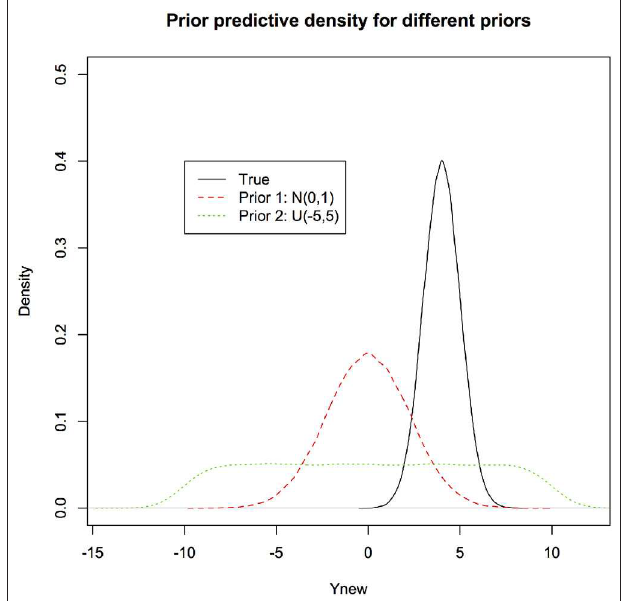
FIGURE 5 | Prior predictive densities for the linear regression through origin example under two different priors. These represent the prior beliefs about the observation to be predicted. The true density (black) is presented for comparison. Prior predictive densities could be close to the true density if the prior distribution on the parameters is “good” and they can be very far if the prior distribution on the parameters is “inappropriate.” These are induced priors on the quantities of interest, namely values of the future data.